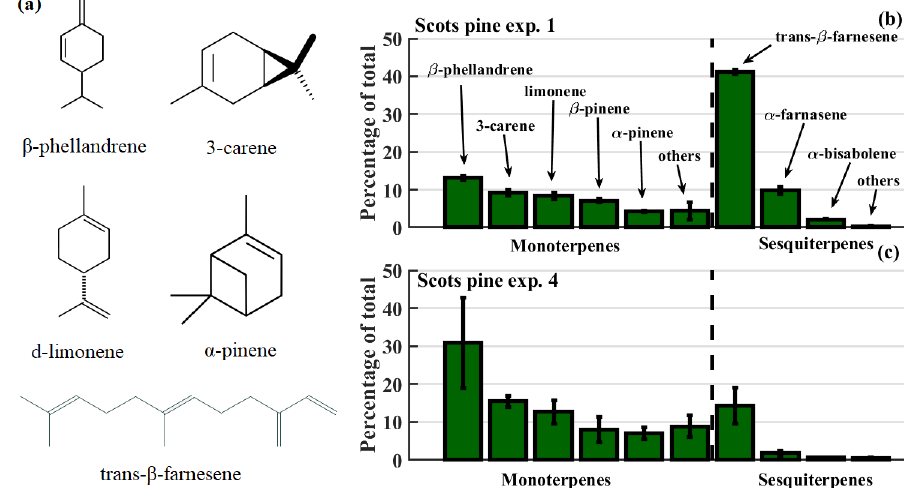
Figure 2. Panel (a) shows the structures of the most abundant monoterpenes and sesquiterpenes in Scots pine emissions, as measured with a TD-GC-MS. Relative mass concentrations of each compound are shown for Scots pine experiments 1 (b) and 4 (c) , the latter following deliberate damage to the plant’s stem. The whiskers show the standard deviation of the